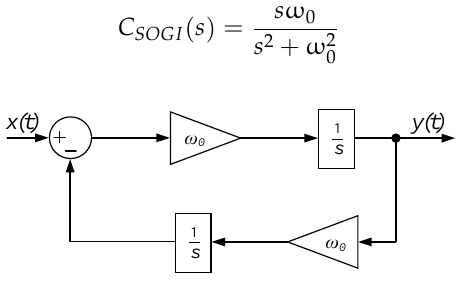
Figure 8. Second order generalized integrator transfer function.